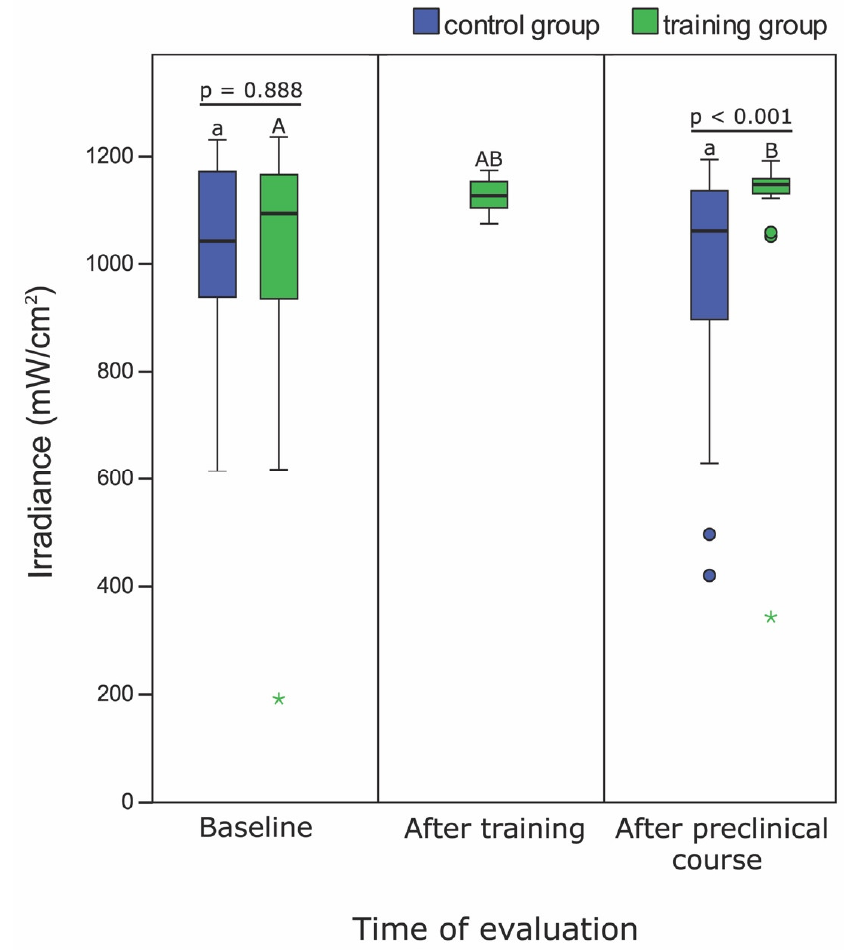
Figure 2. Irradiance (mW / cm 2 ) delivered by the dental students at baseline, after training with the MARC Patient Simulator, and after the 26-day preclinical course. The boxplots show the medians (black lines) with 25% and 75% percentiles (boxes); the whiskers represent 1.5 × IQR (interquartile range), or minima and maxima of the distribution if below 1.5 × IQR; outliers are shown as circles, and extreme outliers are shown as asterisks. Same lowercase letters indicate statistically similar values within the control group, whereas same uppercase letters indicate statistically similar values within the training group. p -values for comparisons between the control and the training group are indicated above the corresponding boxes.